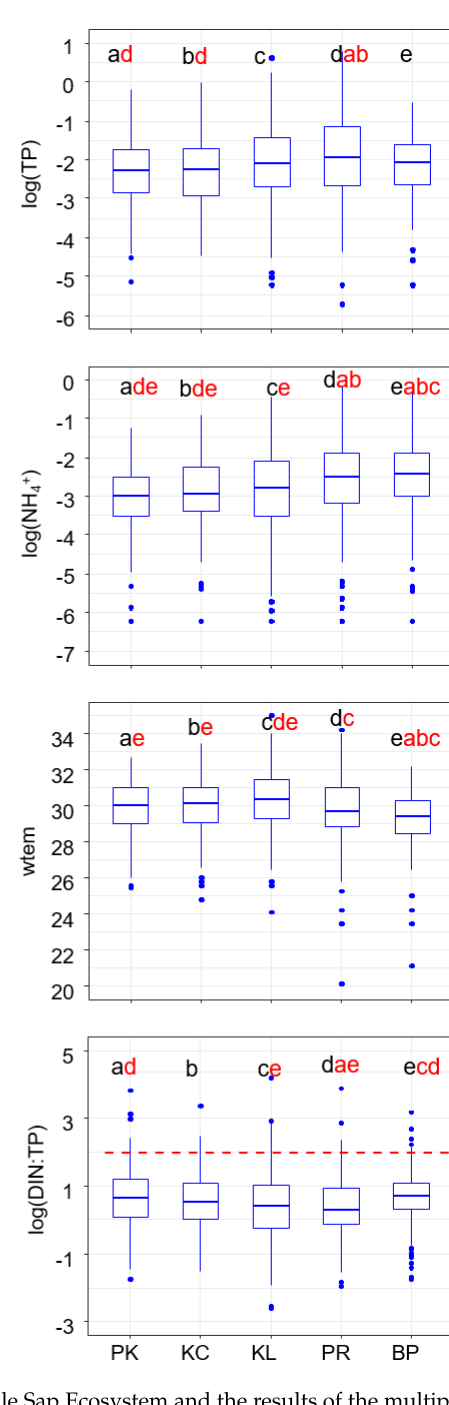
Figure 2. Variability of water quality parameters across the Tonle Sap Ecosystem and the results of the multiple comparison test after Kruskal Wallis test. The red dashed line indicates the DIN:TP ratio value at 7.2. Values above and below 7.2 indicate P-limited and N-limited, respectively. Abbreviations are as follows: PK: Prek Kdam; KC: Kampong Chhnang; KL: Kampong Luong; BP: Back Prea; PR: Phnom Krom. The label “a, b, c, d, and e” in black refer to PK, KC, KL, PR, and BP, respectively. Red letters refer to sites that were significantly different ( p < 0.05). The location of each site is shown in Figure 1.